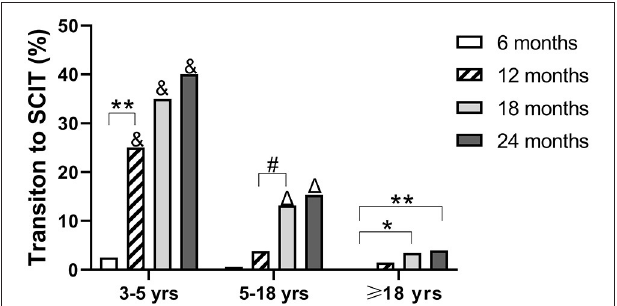
FIGURE 4 | Proportion of patients changing from SLIT to SCIT at different times. Patients were divided into three age groups. * P < 0.05; ** P < 0.01; # P < 0.001; & P < 0.001 compared with the transition rates of children at 5–18 and ≥ 18 years (adult) age groups at the same duration of SLIT; 1 P < 0.001, compared with the transition rates of adults ≥ 18 years at the same